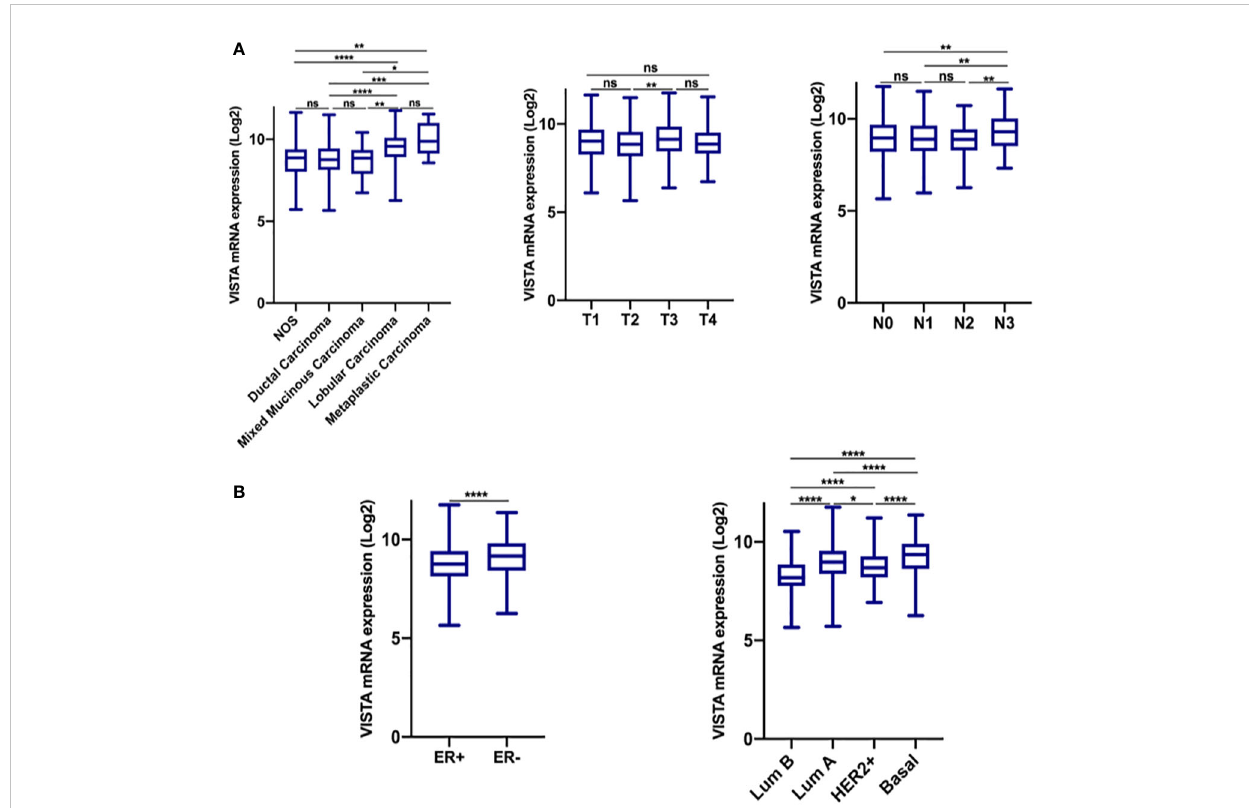
FIGURE 1 VISTA expression is signi fi cantly up-regulated in the breast cancer microenvironment. (A) VISTA expression in the TCGA dataset according to histological type, tumor size, and lymph node status. (B) VISTA expression according to ER status, and molecular subtype. *Indicates p-value <0.05, **Indicates p-value <0.01, ***Indicates p-value <0.001; ****Indicates p-value < 0.0001. ns indicates that the test is non-signi fi